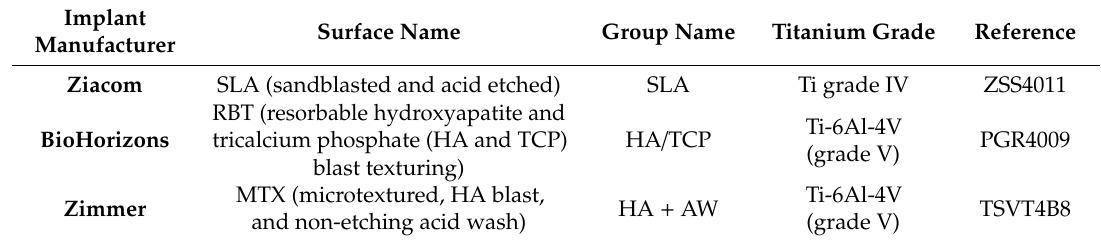
Table 1. Description of the characteristics of the implants analyzed in the